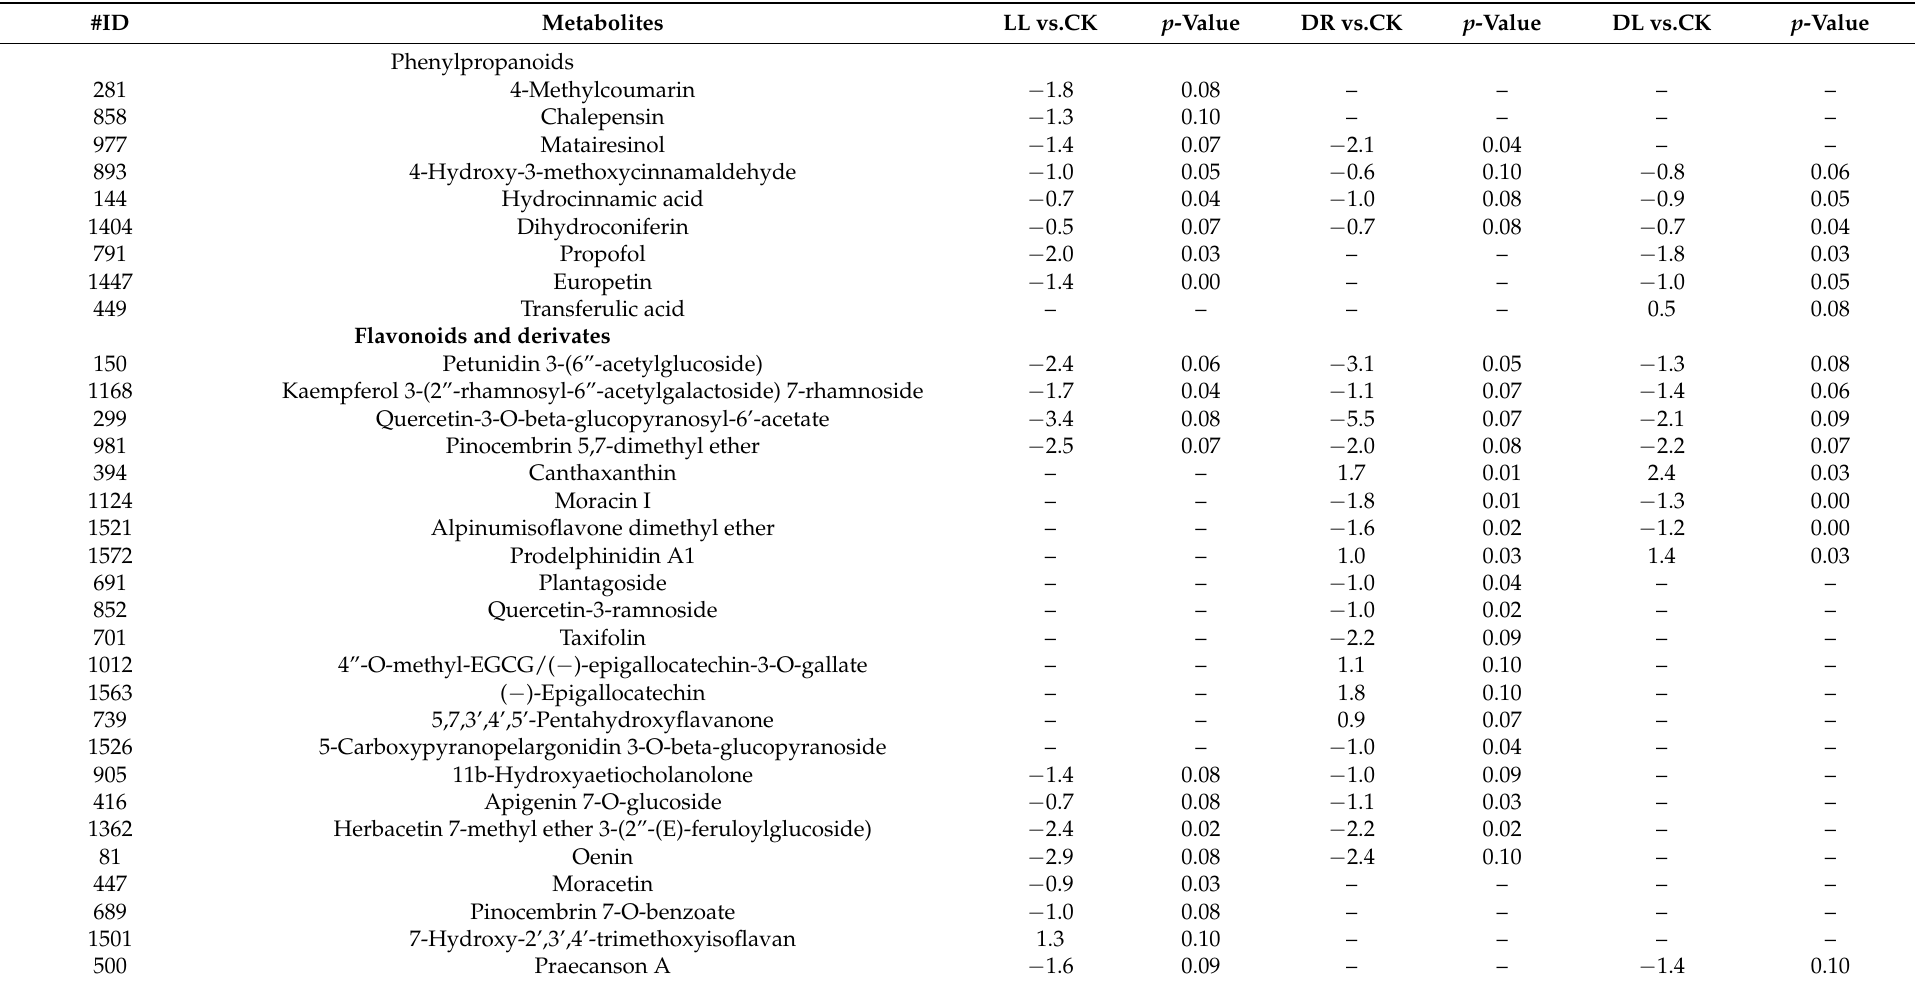
Table 1. Fold changes of polyphenol metabolites in Masson pine seedlings under low light, drought, and combined stress compared to control. CK: control; LL: low light; DR: drought; and DL (DR + LL): the combined stress of drought and low light. Every treatment included three individual repeats, and 20 leaves were collected from